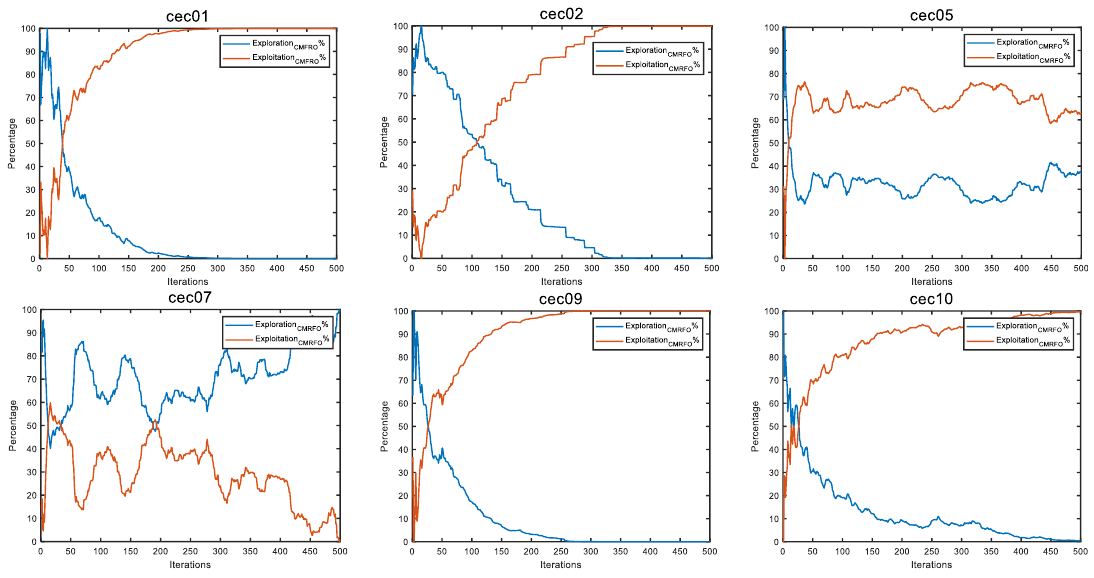
Table 5. Description of parameter settings.